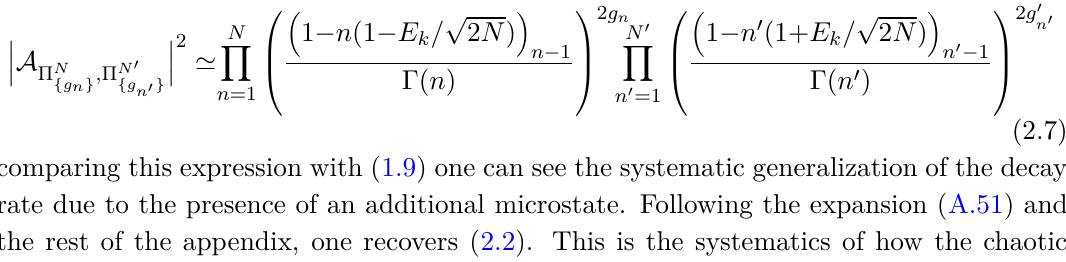
JHEP04(2023)052